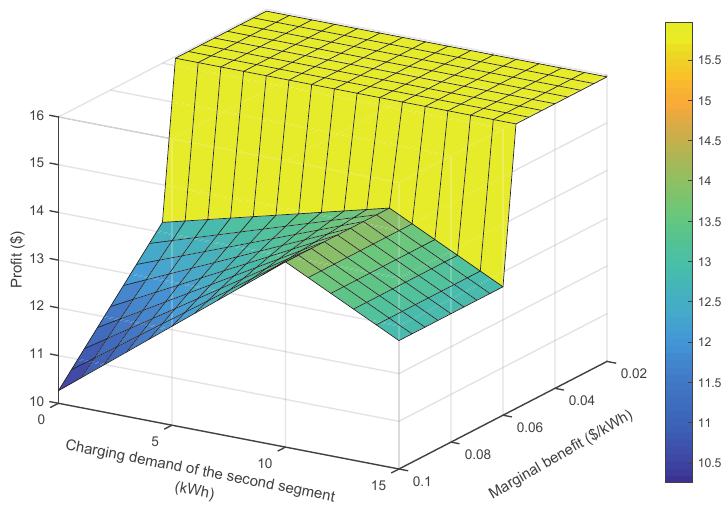
Figure 13. Profit of the PEV owner as a function of marginal benefit and charging demand.